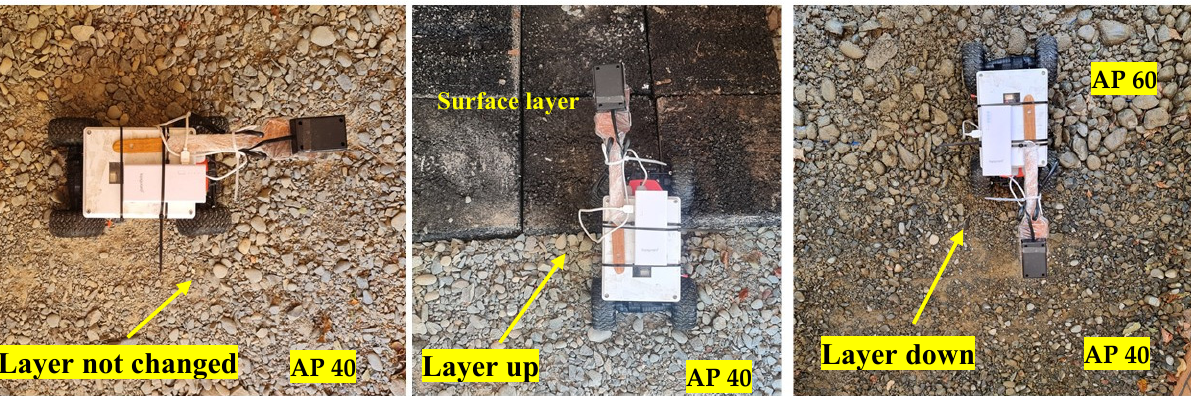
Figure 7. Data collection in a controlled environment.